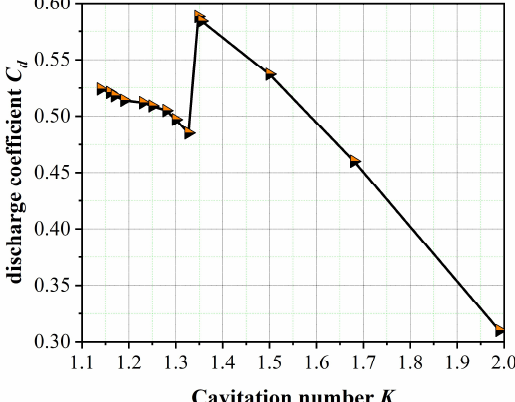
Figure 11. Relationship between discharge coefficient and cavitation number of a single cylindrical nozzle.